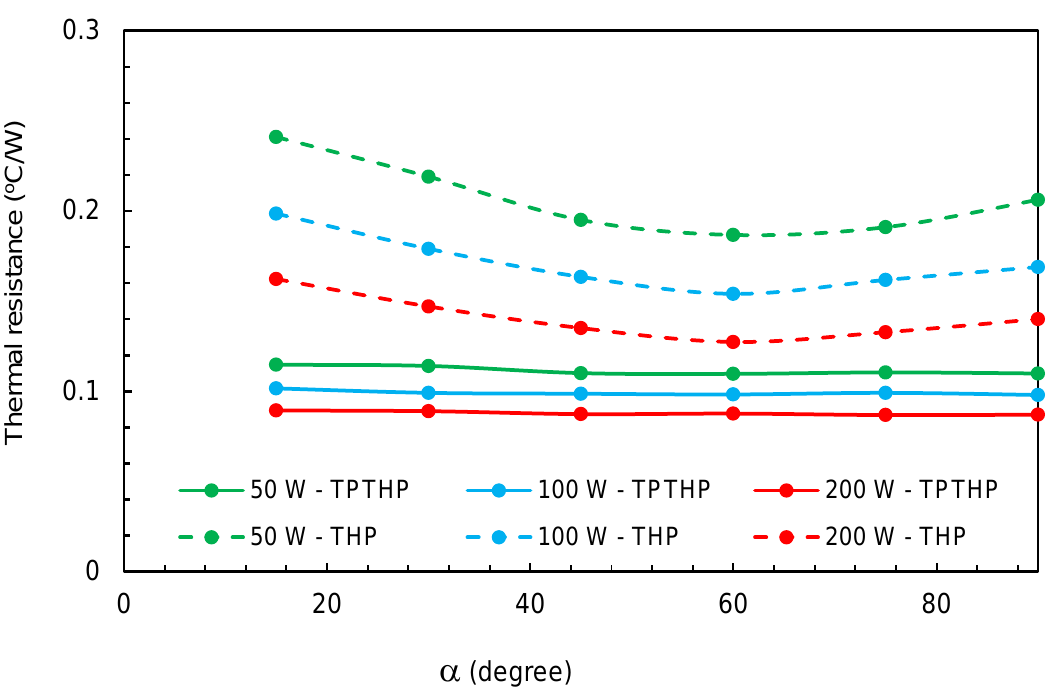
Figure 13. The variation of thermal resistance with inclination angle for the TPTHP and THP (FR = 70%).